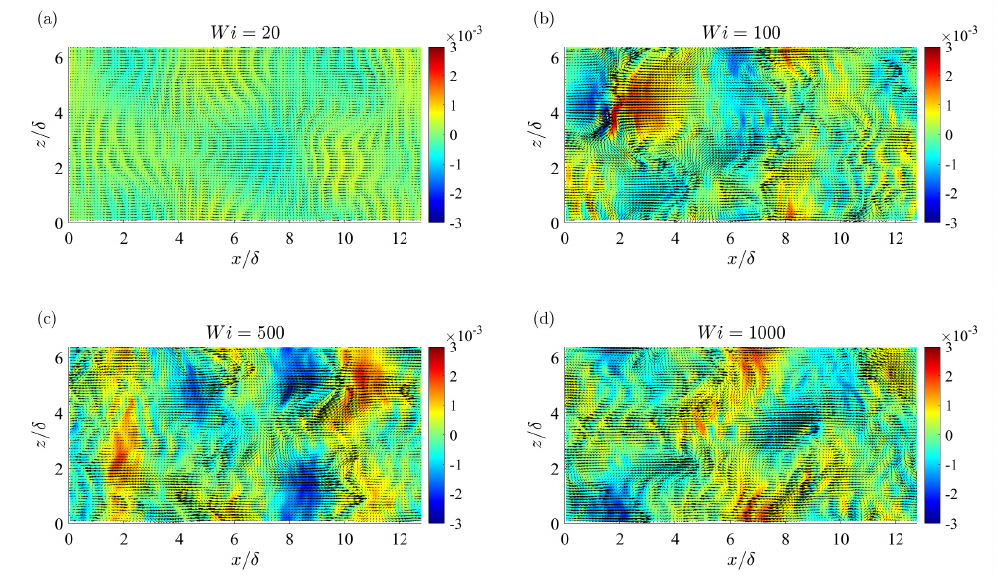
Figure 8. Snapshots are the same as Figure 7, but for Re = 100 and ( a ) Wi = 20, ( b ) Wi = 100, ( c ) Wi = 500, and ( d ) Wi =